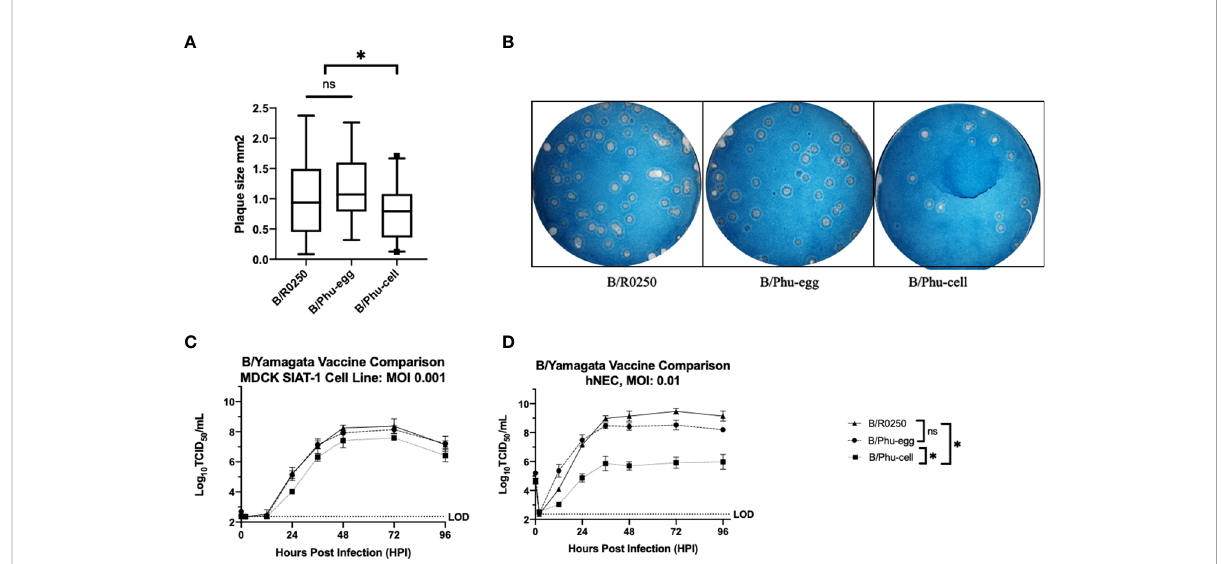
FIGURE 4 Investigating Viral Phenotype Differences: B/Yamagata (A) Comparison of plaque sizes formed by clinical isolate, egg-adapted vaccine strain and cell-adapted vaccine strain from B/Yamagata, B/R0250, B/Phu-egg and B/Phu-cell respectively. (B) Images of plaques were analyzed with ImageJ. Representative wells shown. Experiments were completed in triplicate. (C) Low MOI Growth Curve comparing B/R0250, B/Phu-egg and B/Phu-cell on MDCK-SIAT-1 Cell line. Growth curves were completed in triplicate. Statistical signi fi cance of growth curves calculated on GraphPad Prism using a two-way Anova and Tukey ’ s multiple comparisons test. (D) Low MOI growth curves on hNEC ALI culture. Growth curves were completed in duplicate. Statistical signi fi cance was calculated using the same methods as the MDCK SIAT-1 growth curves. An * indicates p<0.05 and ns indicates a not signi fi cant